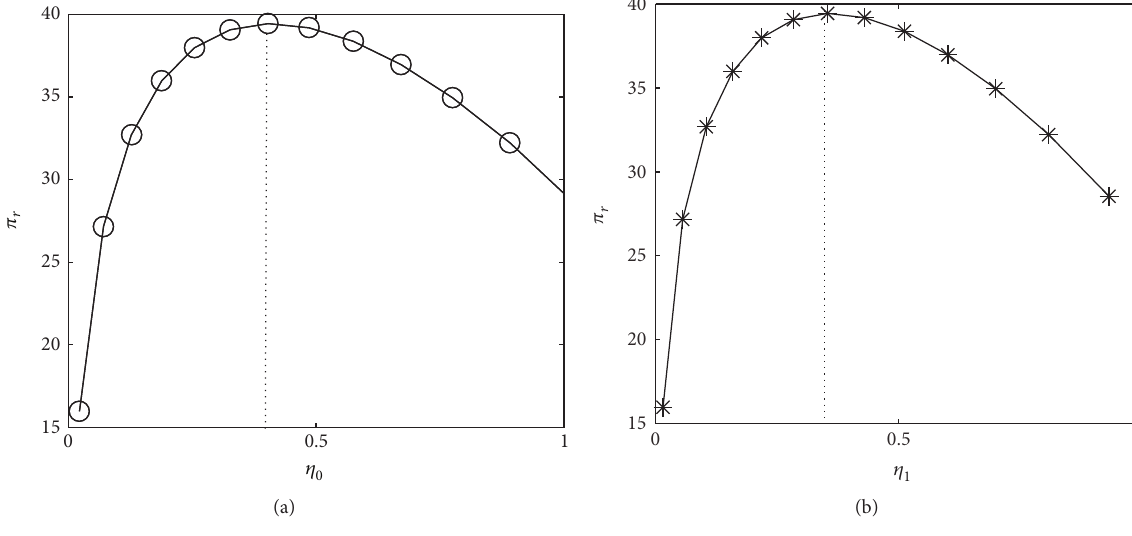
Figure 3: Impact of 𝜂 0 and 𝜂 1 on retailer’s profit 𝜋 𝑟